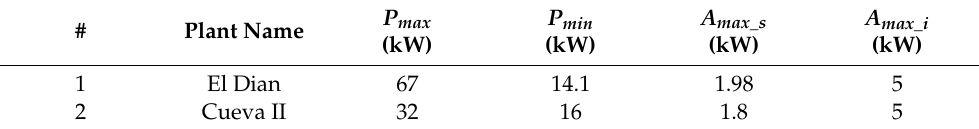
Table 4. Measures of typical users load demand.